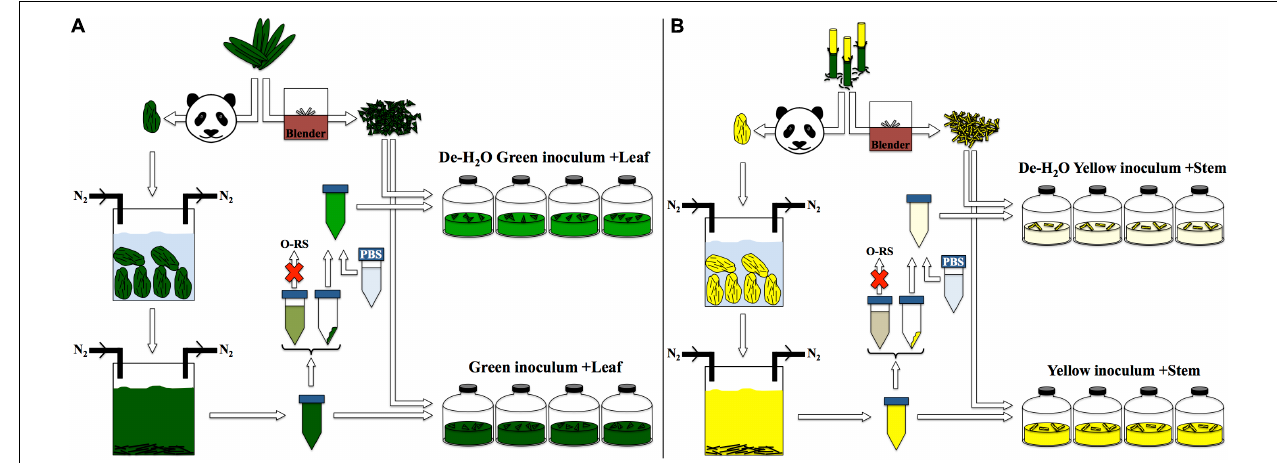
FIGURE 2 | Experimental setup for laboratory-scale fermentation: (A) entirely green stools derived from predominant ingestion of P. bisettii green leaves were collected and immersed in anaerobic, sterile water. Microbial cells attached to indigested bamboo matter were suspended in the liquid phase along with organics generated in the panda gastrointestinal tract. This mixture was used as inoculum in experiments termed ‘Green inoculum + Leaf’ and supplied with freshly grinded P. bisettii bamboo green leaves in multiple independent replicates. In a parallel experiment, such inoculum was centrifuged to separate the organic-rich supernatant (O-RS) from the pellet containing microbial cells and small fragments of indigested bamboo. This dewatering procedure aimed at reducing the impact of the organics derived from the giant panda digestion on the lab-scale experiments. The pellet was resuspended in a phosphate buffer saline (PBS) solution, and used as alternative inoculum supplied with freshly-grinded P. bisettii bamboo green leaves in tests termed ‘De-H 2 O green inoculum + Leaf.’ An identical approach was used for yellow stools and yellow pith (B) .